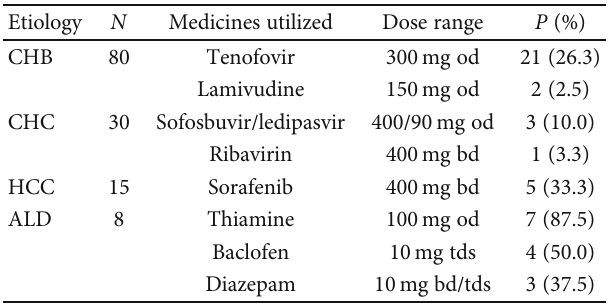
Table 2: Medicines prescribed for etiologies of liver cirrhosis ( n = 133